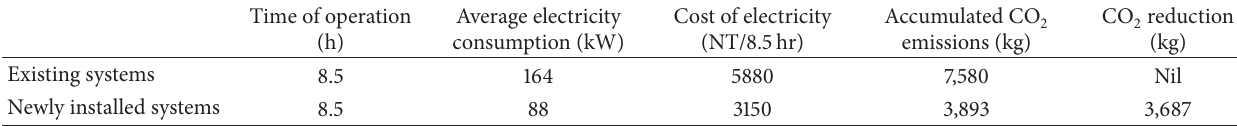
Table 4: Cost of electricity for office buildings.